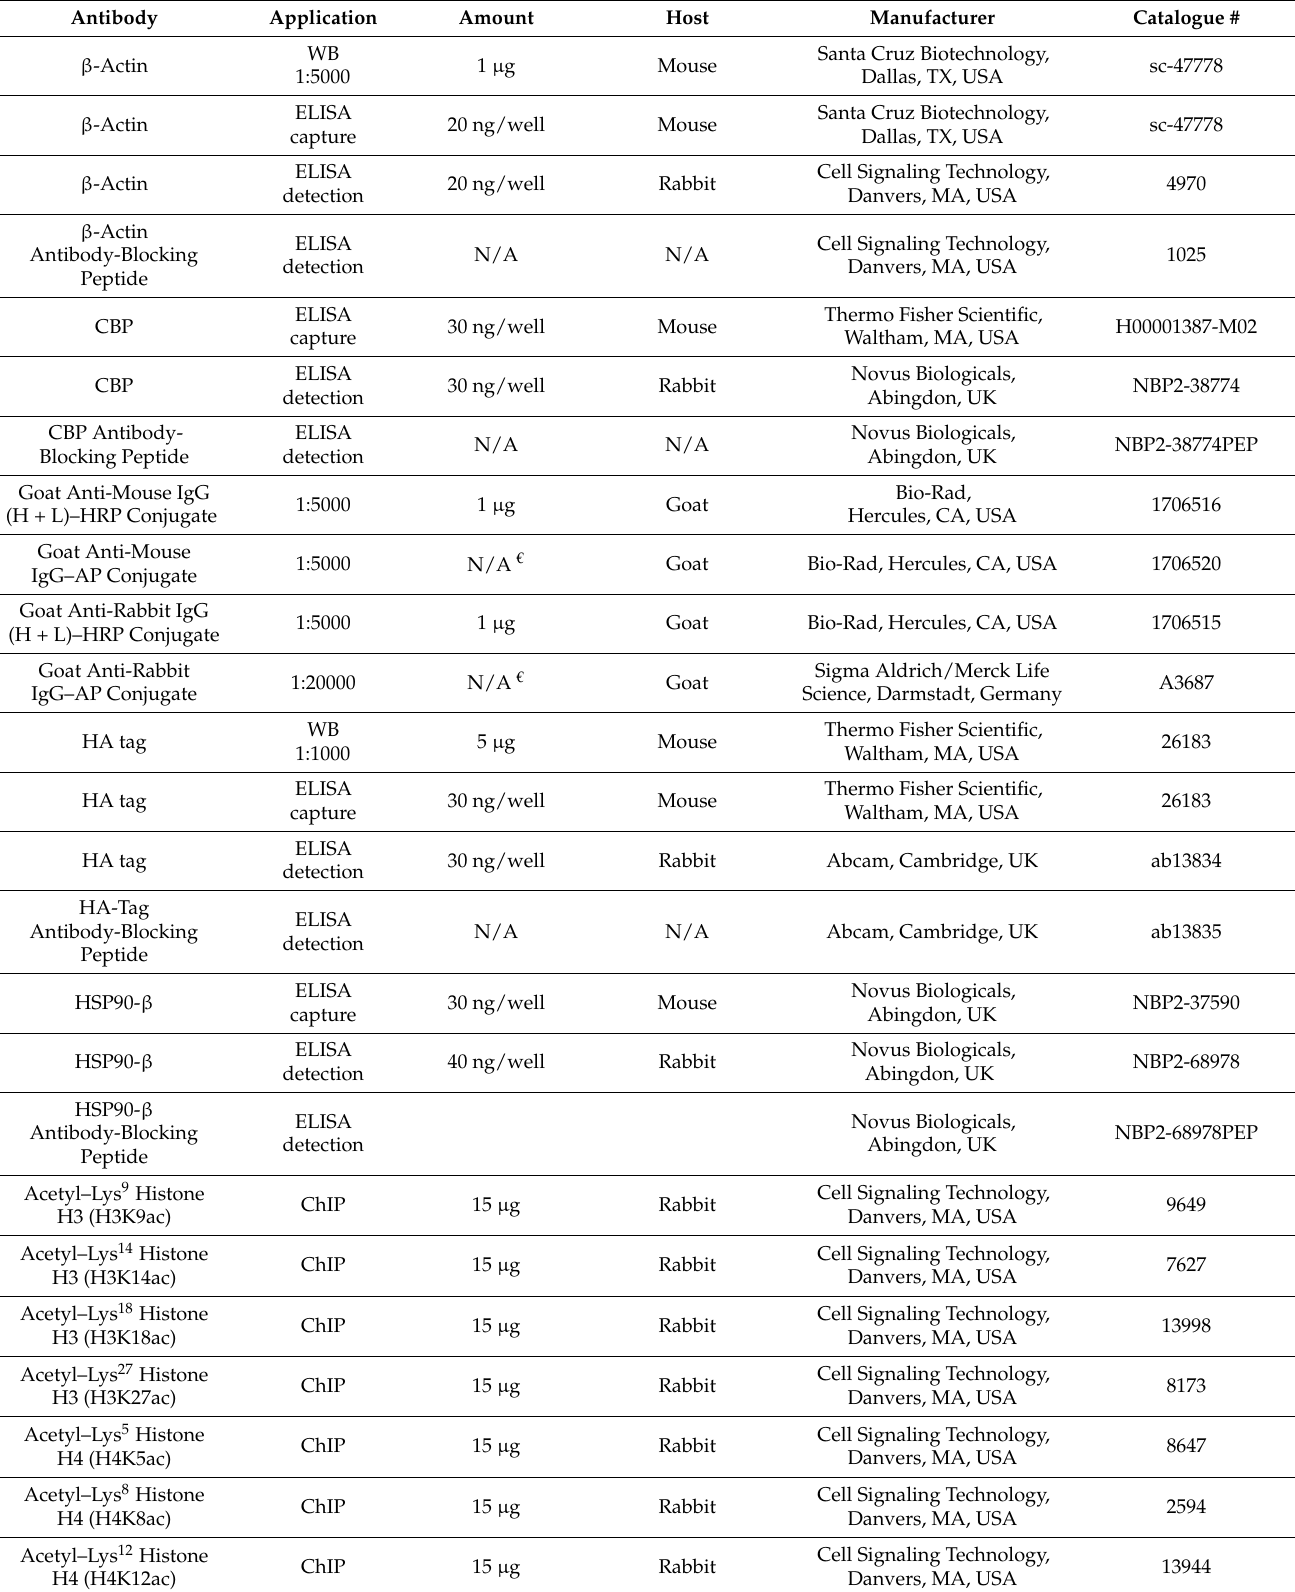
Table 2. List of antibodies and antibody-blocking peptides used in the